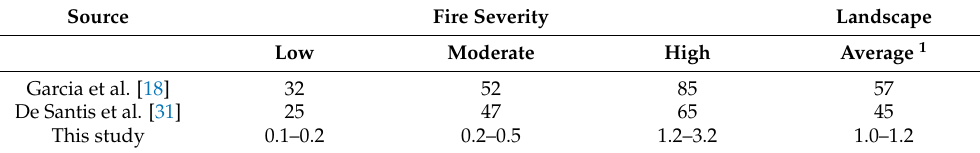
Table 4. Comparison of combustion rates (percentage) at stand- and landscape-level at Rim Fire. Source Fire Severity Landscape Low Moderate